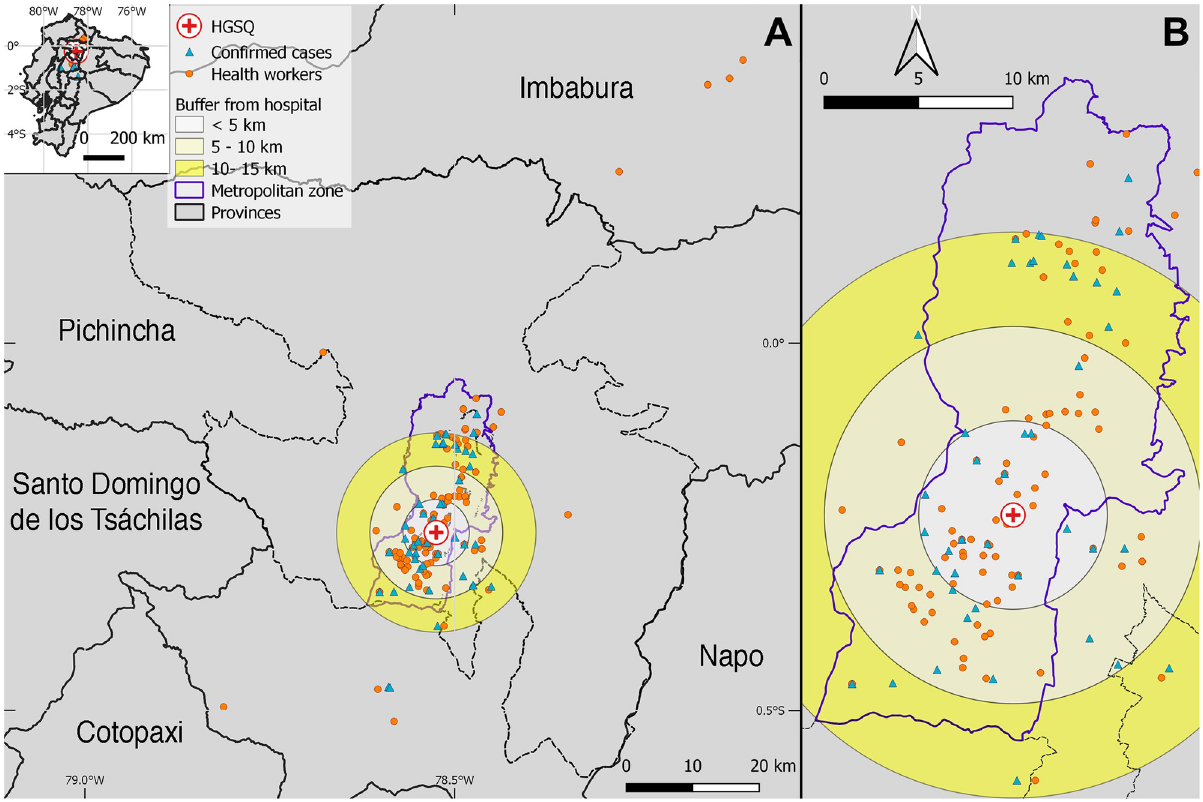
Fig 2. Distribution of 54 COVID-19 cases and 126 health workers from the Hospital General del Sur de Quito (HGSQ), in Quito, Ecuador. Buffers represent 0–5, 5–10, and 10–15 km distances around the HGSQ (red cross) and encompass the amount of population living in those areas according to Ecuadorian estimates for 2020. (A) Some health care workers (orange circles) traveled across different provinces to the HGSQ. For the date of data collection, COVID-19 cases (blue triangles) came from different regions of the entire metropolitan zone of Quito municipality (B).